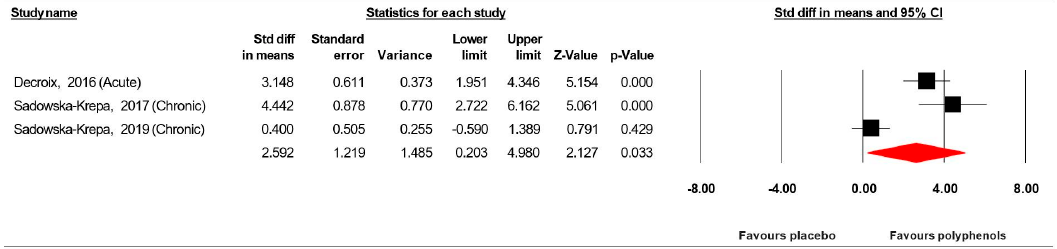
Figure 10. Forest plot of studies investigating the effect of (poly) phenols-rich supplementation on brain-derived neurotrophic factor (BDNF).